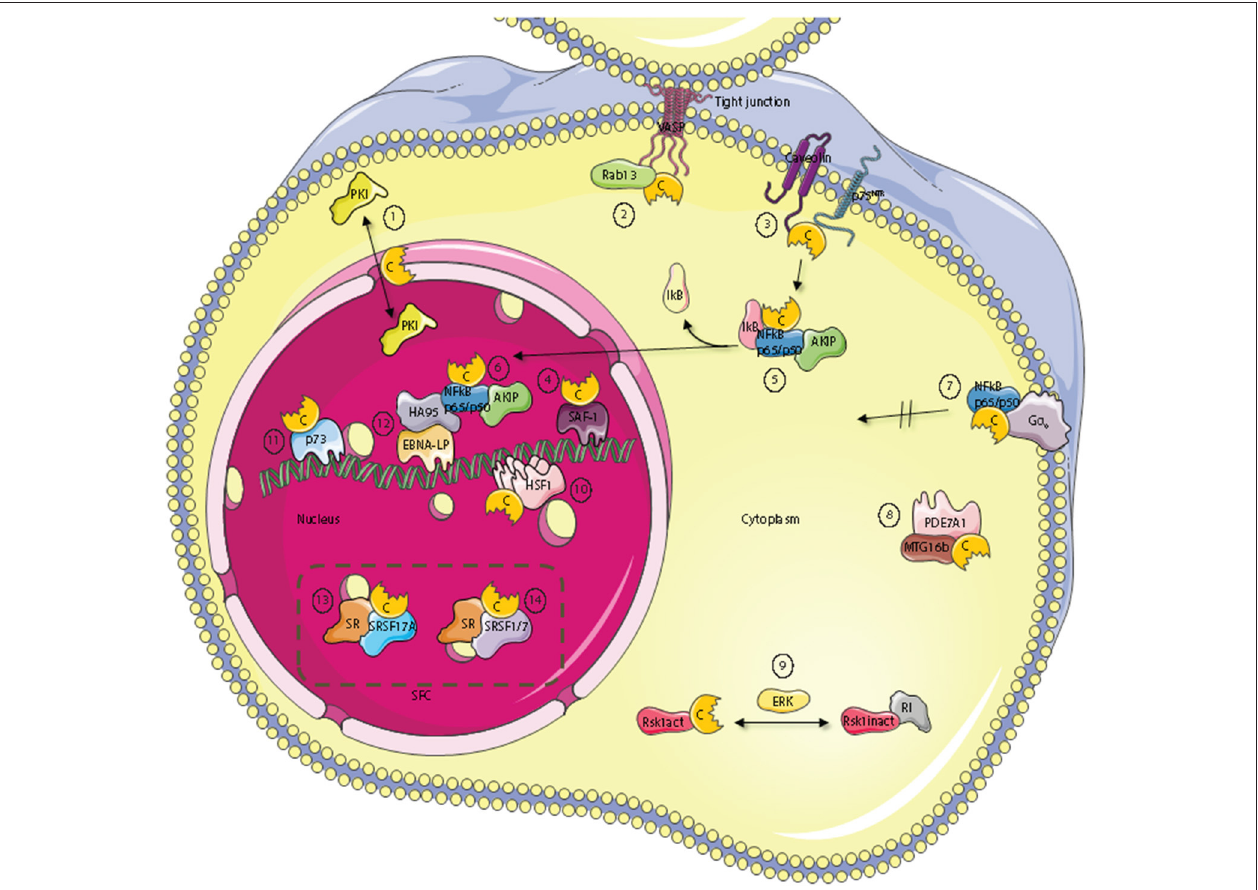
FIGURE 2 | Subcellular localization of C kinase anchoring proteins—C-KAPs. The PKA C subunit associates and regulates the activity of proteins located to multiple cellular compartments and molecules. These compartments include the outer cell membrane, the cell cytoplasm and the cell nucleus. In the nucleus, C-KAPs co-locate the PKA C subunit with DNA and components of the splicing factor compartment (SFC). In the cytoplasm the PKA C subunit in addition to associate with the PKA R subunit interacts with the PKA inhibitor PKI (1), the small G protein Rab13 (2), PDE7A1 (8) the Rsk1 kinase through regulation by ERK (9), and finally IkB (5) which is a component of the cytoplasmic NFkB/AKIP complex. In the outer membrane compartment PKA C subunits associate with caveolin-1, p75 NTR (3), and the heterotrimeric G protein G α 0 (7). In the nucleus, the PKA C subunit regulates DNA activity through interaction with SAF-1 (4), HSF-1 (10), HA95 (12), and p73 (11). Finally, the PKA C subunit is also involved in regulating mRNA splicing in SFC by direct interaction with serine and arginine (SR) proteins such as SFSR17A (13), SRSF1 and SRSF7